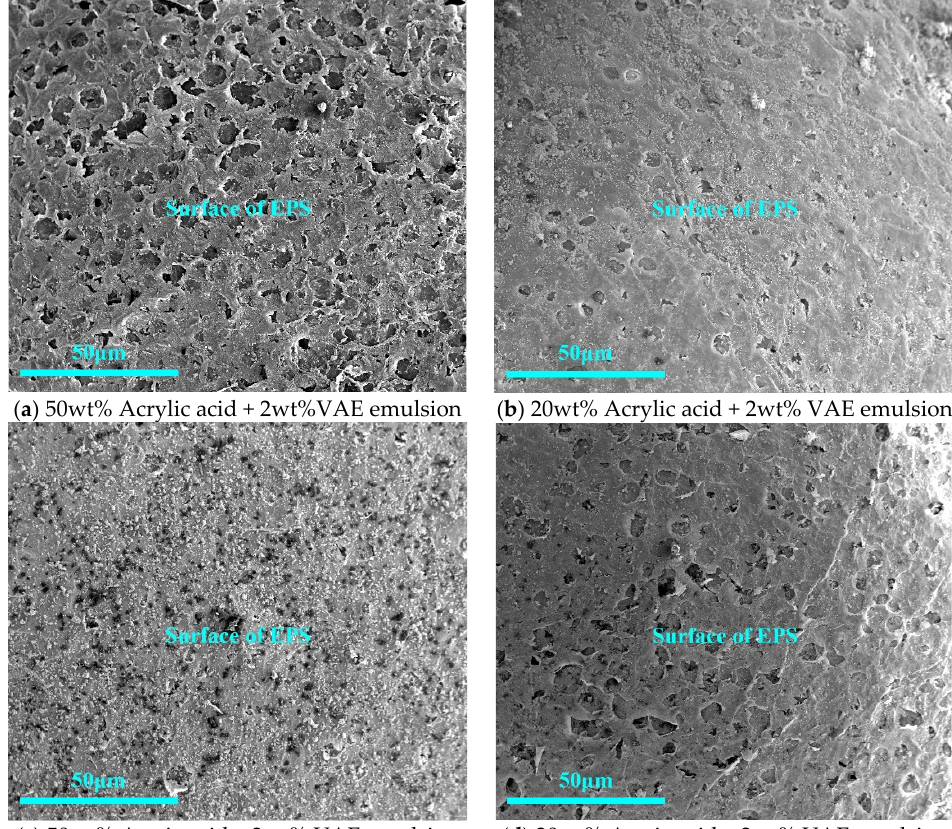
Figure 9. Microstructure of interface treated with an organic acid interface agent.